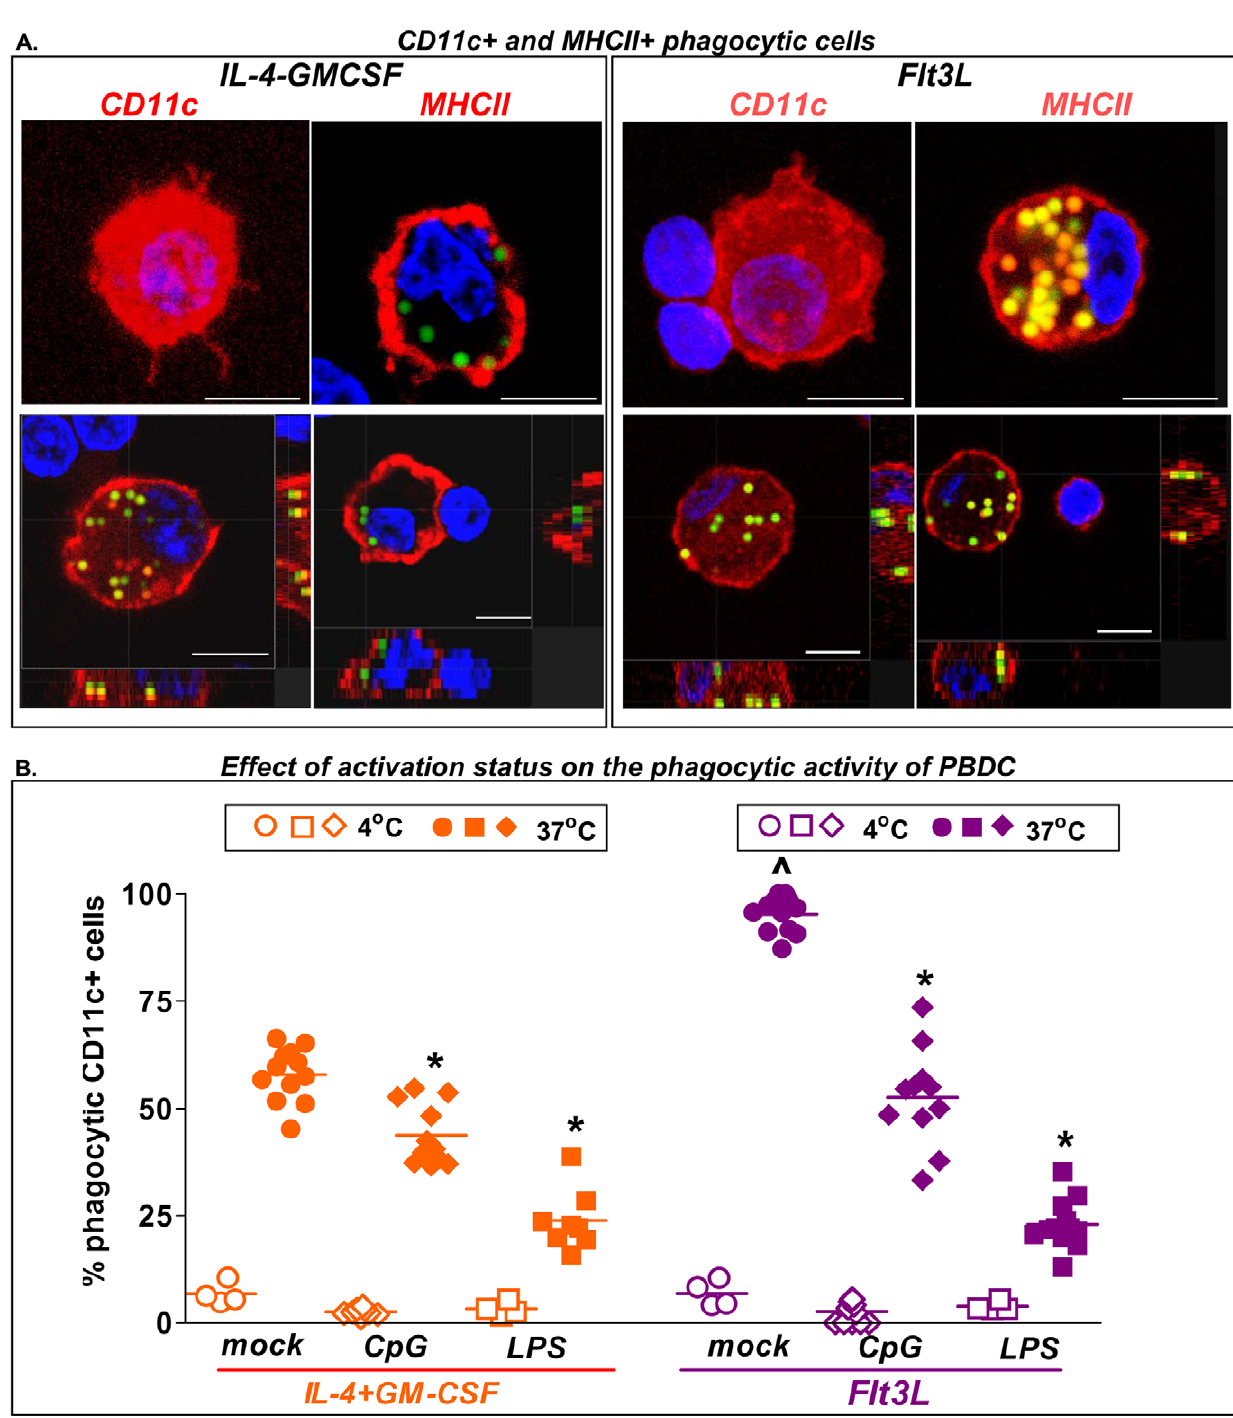
Figure 5. DC phagocytic activity. Peripheral blood cultures were collected after 7 days in culture with recombinant canine IL-4 and GM-CSF or Ad.hFlt3L conditioned medium and incubated for additional 24 h without added cytokines in the absence (mock) or presence of CpG 2216 or LPS. Activated dog DCs were mixed with 1.0 m m yellow-green fluorescent FluoSpheres for 4 hrs at 4 u C or 37 u C. A , Confocal microphotographs show CD11c + and MHCII + cells (red) containing yellow-green beads in their cytoplasm. Nuclei were stained with DAPI (blue). Scale bars: 10 m m. B , Scatter plot shows the quantification of CD11c + DCs containing yellow-green fluorescent FluoSpheres in their cytoplasm. *p , 0.05 vs mock ‘ p , 0.05 vs. IL-4/ GM-CSF (Two-way ANOVA followed by Tukey’s Multiple Comparison test).